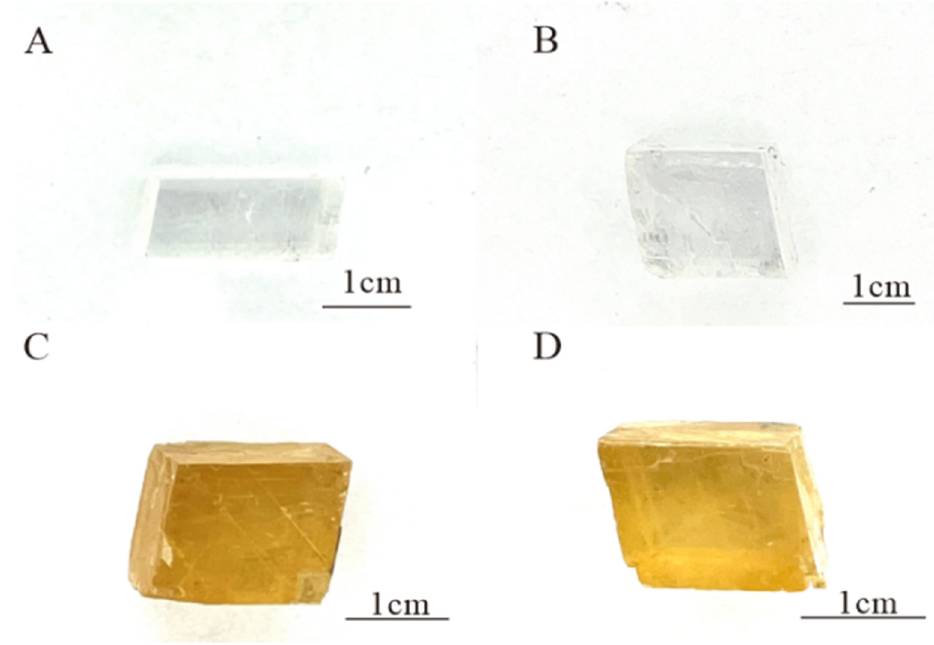
Figure 1. The calcite crystals FJ-1 ( A ), FJ-2 ( B ), FJ-3 ( C ), and FJ-4 ( D ).